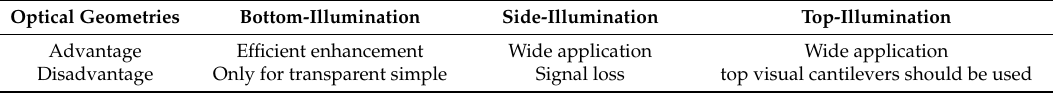
Table 1. The advantage and disadvantage of the different optical